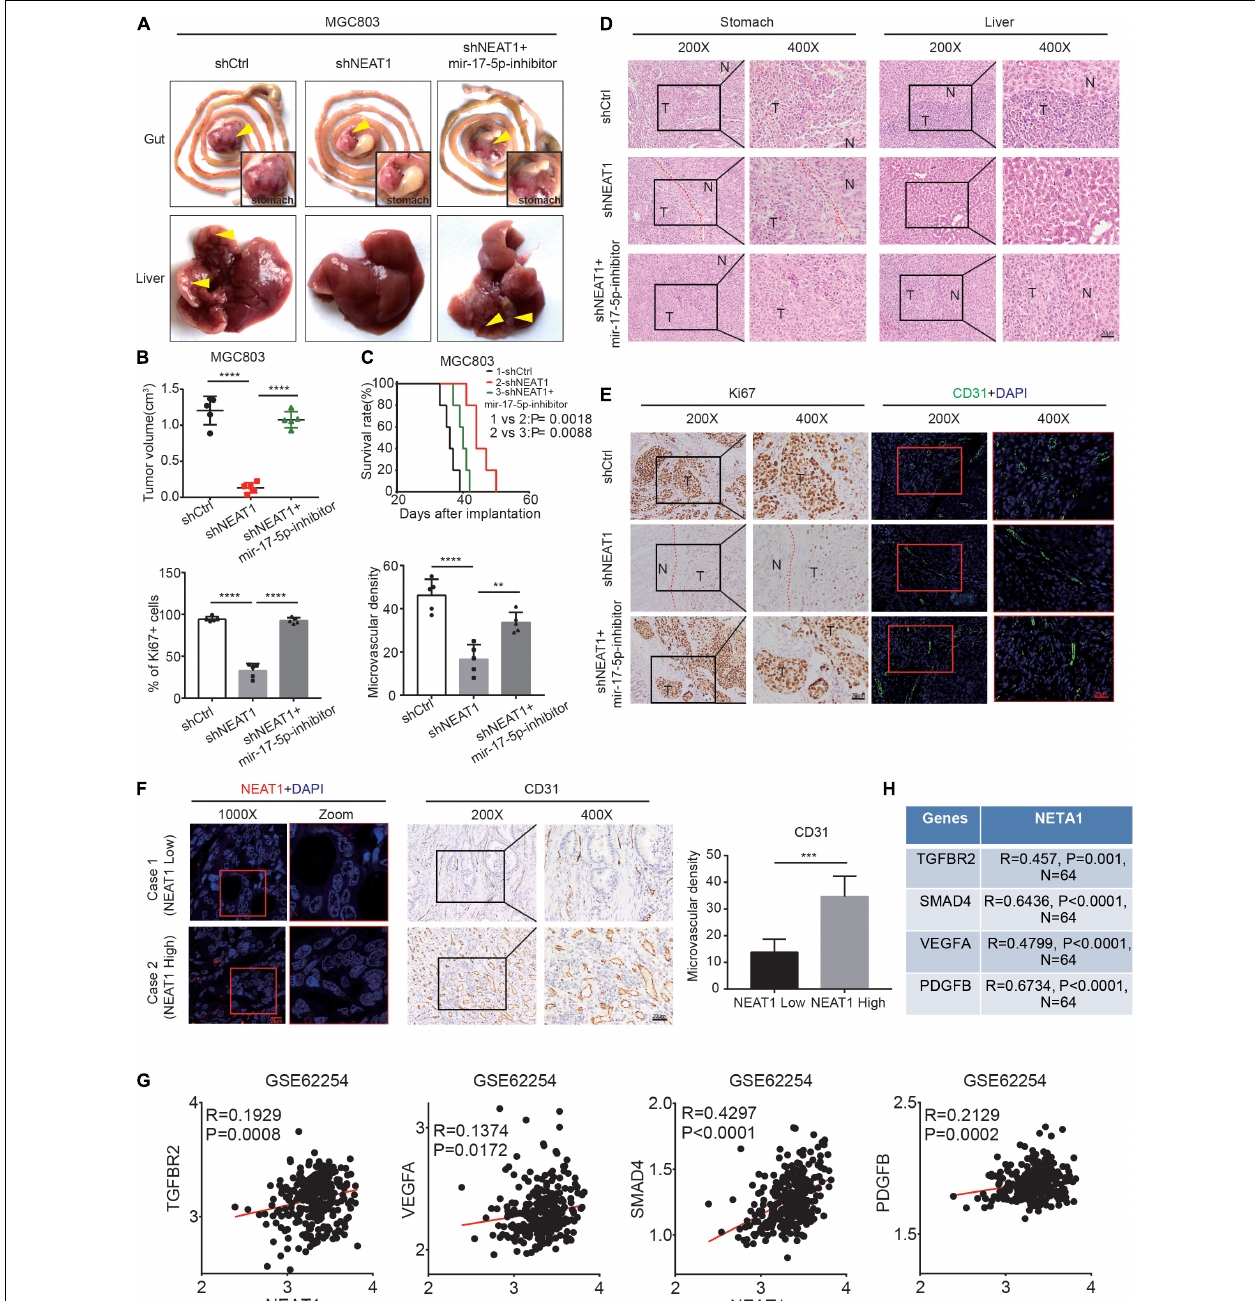
FIGURE 5 | LncRNA NEAT1 promotes GC angiogenesis via the miR-17-5p/TGF β R2 axis in vivo . (A) Gross of GC orthotopic tumors and corresponding livers. Representative images were shown. (B) Size analyses of the GC orthotopic tumors. (C) Kaplan-Meier survival analysis of mice bearing xenografts. n = 5 for each group. (D) H&E-stained paraffin-embedded tumor obtained from xenograft tumor (E) IHC and IF staining for ki67 and CD31 expression in xenograft tumor. (F) Representative images of GC patients’ tumors with IHC and FISH staining. (G) Pearson correlation analysis was conducted to analyze the relation between LncRNA NEAT1, TGF β R2, VEGF, and Smad4 in GC GEO dataset. (H) Pearson correlation analysis was conducted to analyze the relation between LncRNA NEAT1, TGF β R2, VEGF, and Smad4 in GC tissues. ** P < 0.01, *** P < 0.001, **** P < 0.0001.